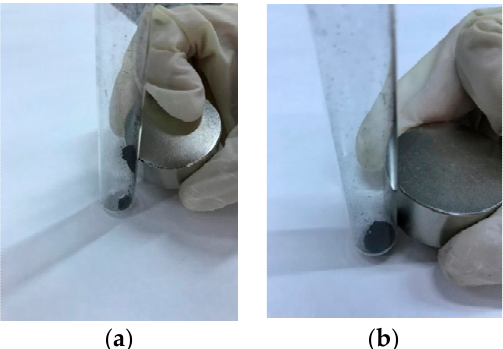
Figure 6. Representative behavior of ( a ) pyrolyzed ones (CA–HC–Fe 3 -600) and ( b ) nonpyrolyzed HCs (CA–HC–Fe 3 ) .